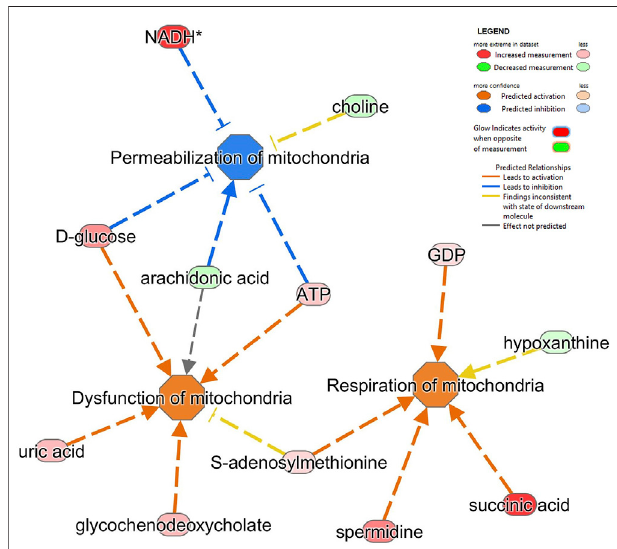
FIGURE 6 | Alterations in several metabolites identi fi ed impacts on different mitochondrial pathways in SH-SY5Y MitoPPX cells. Respiration of mitochondria, dysfunction of mitochondria and permeabilization of mitochondria (all of them FDR < 0.001) were the top three signi fi cantly affected mitochondrial-related pathways shown by ‘ disease and function ’ analysis in IPA software from the metabolomics data.